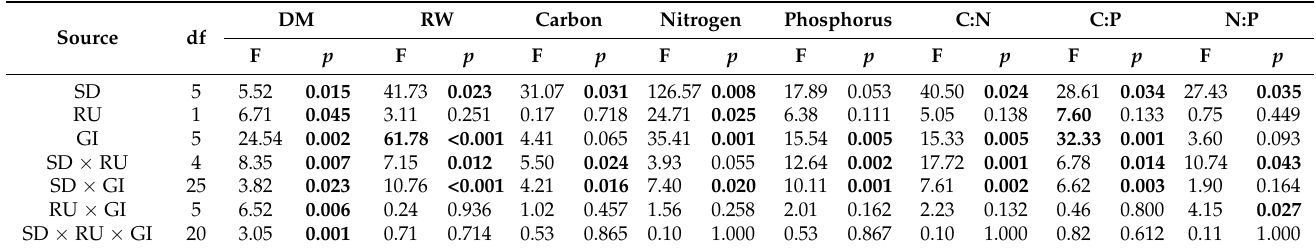
F-values (F) and p -values ( p ) are given. Significant p -values ( p < 0.05) in